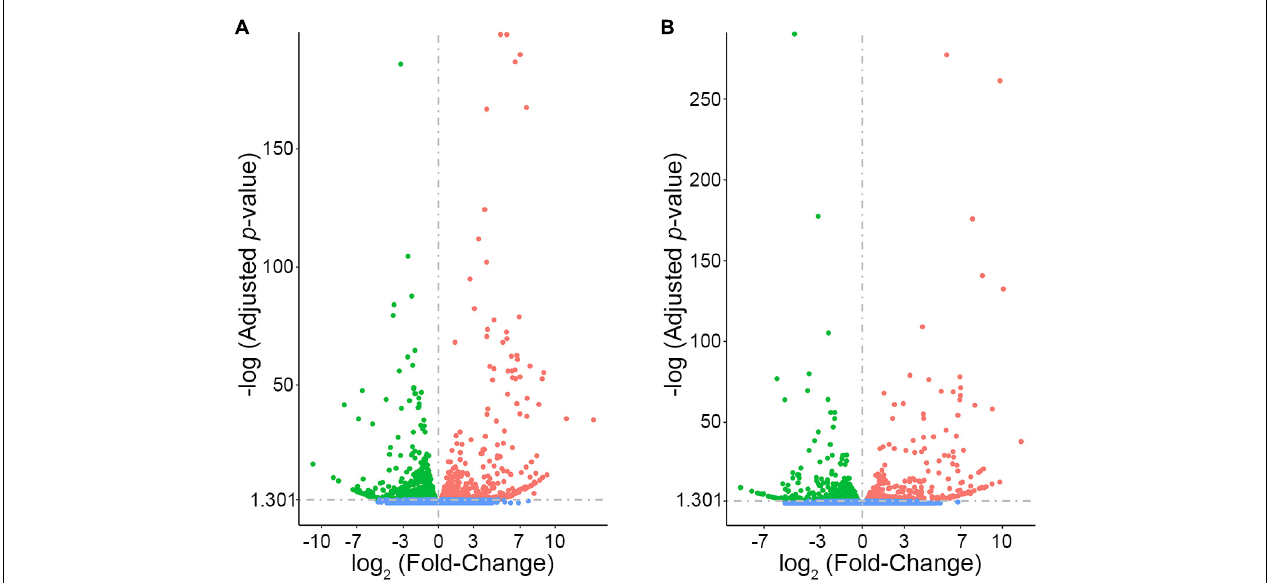
FIGURE 5 | RNA sequencing identifies transcripts showing strain-specific differences in cerebral cortex gene expression. The volcano plots show differential gene expression for either WSB vs. B6 (A) or C3H vs. B6 (B) from brain cortex determined by RNA sequencing analysis. Each dot represents a different gene with log 2 fold-changed plotted against log 10 p -value. (A) The total number of significantly differentially expressed genes across the mouse genome between WSB and B6 is 1,716 genes, containing 782 upregulated genes indicated by red dots and 934 downregulated genes indicated by green dots, relative to B6. Blue dots (25,956) indicate no significant difference in genes compared between WSB and B6. (B) The total number of significantly differentially expressed genes across the mouse genome between C3H and B6 is 2,180 genes, containing 980 upregulated genes indicated by red dots and 1,200 downregulated genes indicated by green dots, relative to B6. Blue dots (25,433) indicate no significant difference in genes compared between C3H and